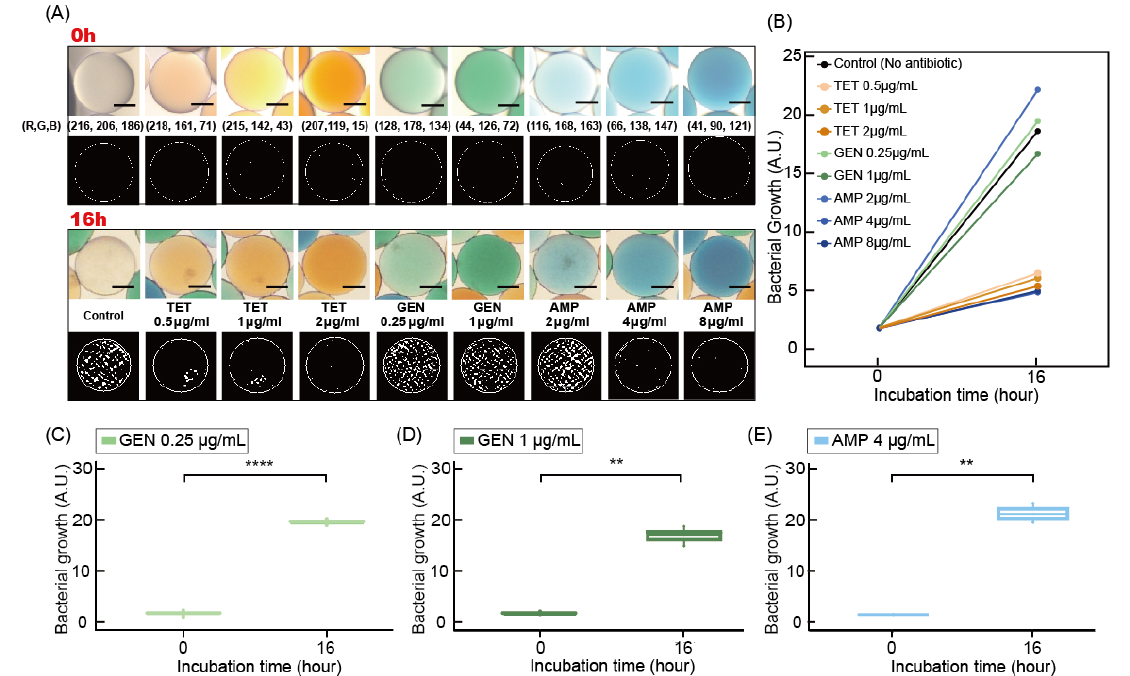
Figure 4. The measurement of bacterial growth in color-coded droplets with antibiotics. ( A ) Microscopic images of the color-coded droplets with different antibiotics and their concentration. Scale bars represent 100 µm. The lower row shows the microscopic images of the color-coded droplet after 16 h of incubation. The binary image shows the bacterial cells from the image processing. ( B ) Graph of bacterial growth at 0 and 16 h of incubation. Statistical analysis of bacterial growth at 0 and 16 h of ( C ) 0.25 µg/mL, ( D ) 1 µg/mL of gentamicin, and ( E ) 4 µg/mL of ampicillin ( p < 0.001).